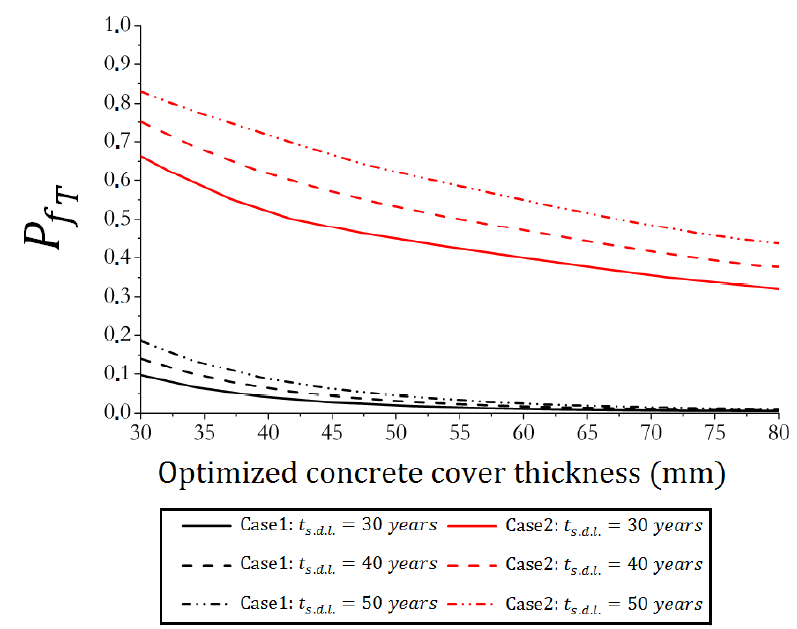
Figure 6. Optimised concrete cover thickness. fT P condition. Case 1 and Case